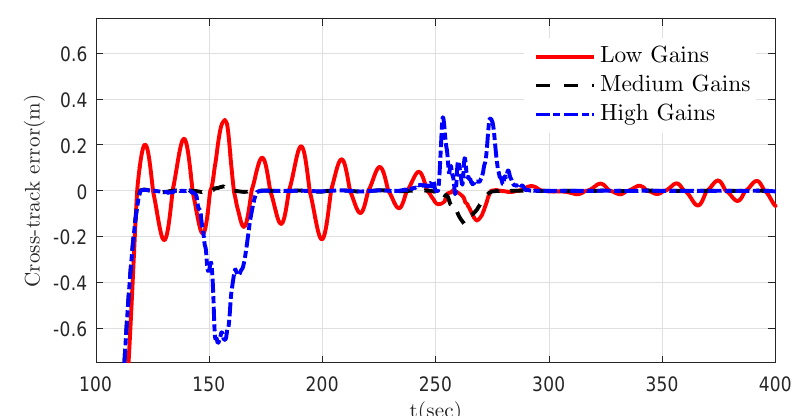
Figure 9. Cross-track error comparisons with different FGO